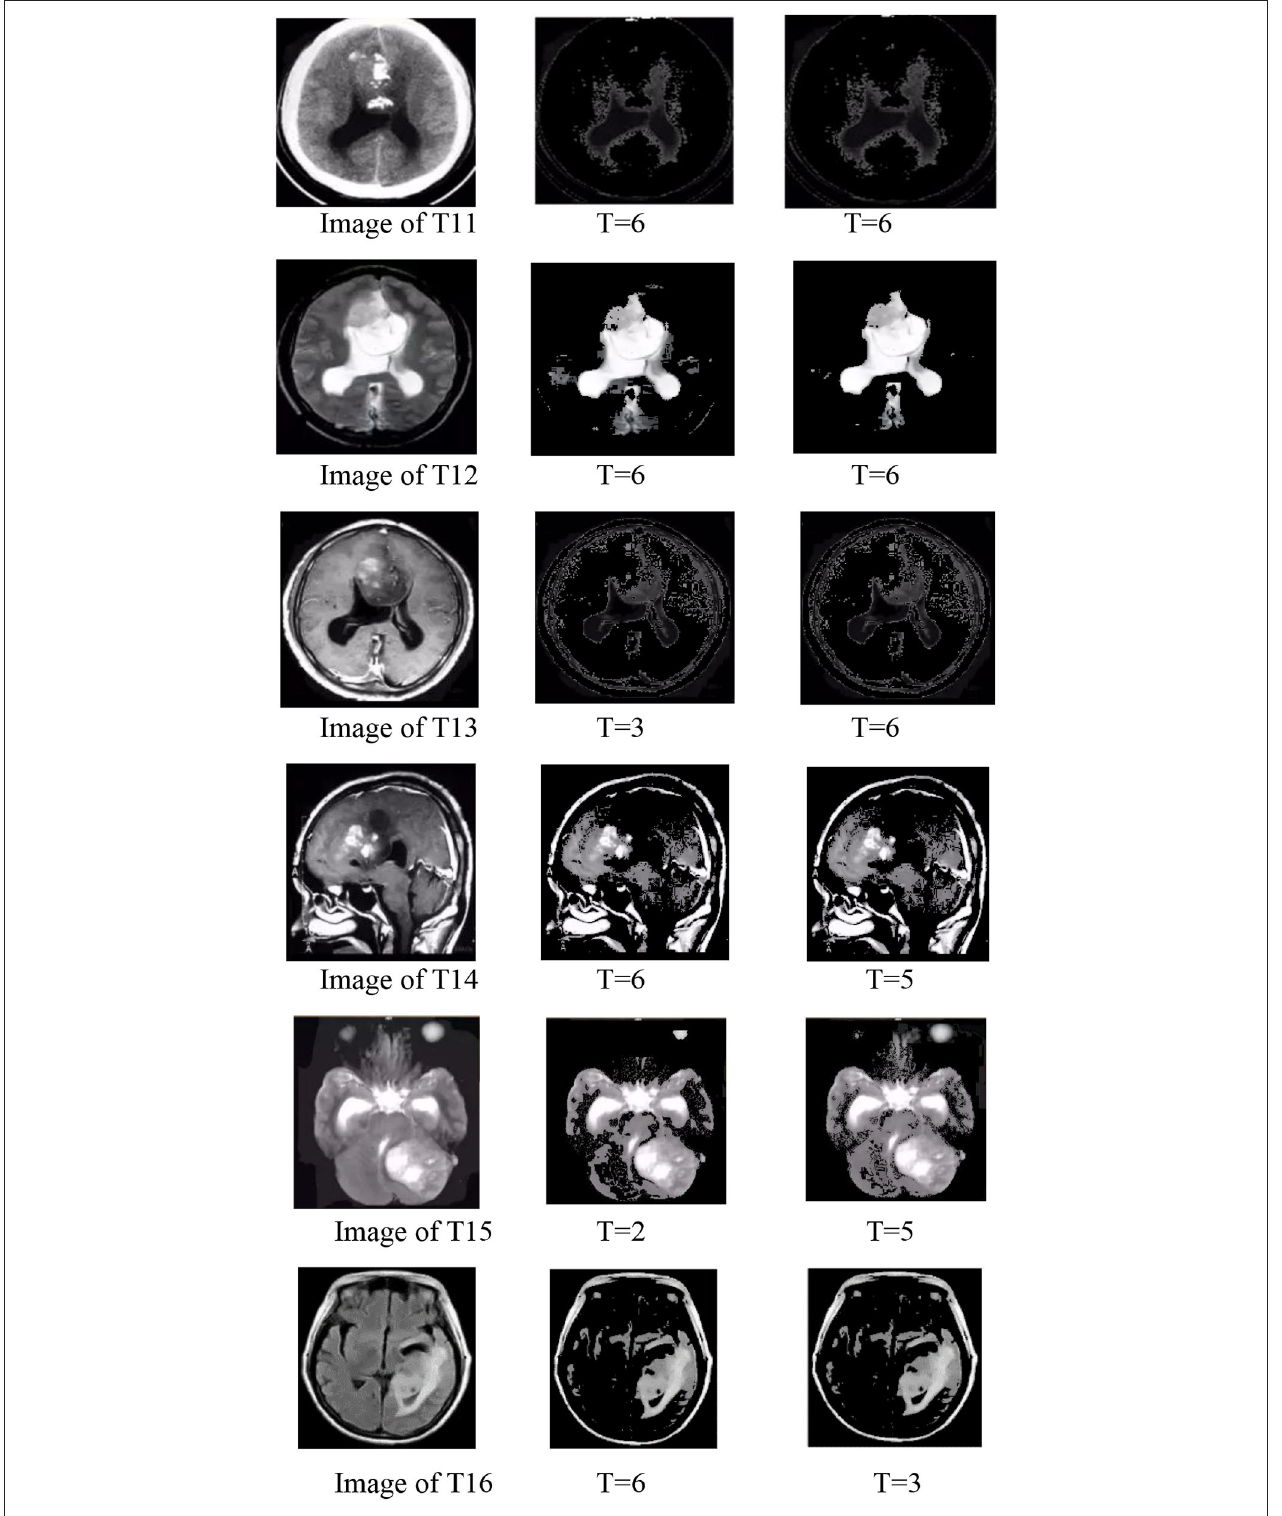
FIGURE 14 | Images of group 3 and their best value of